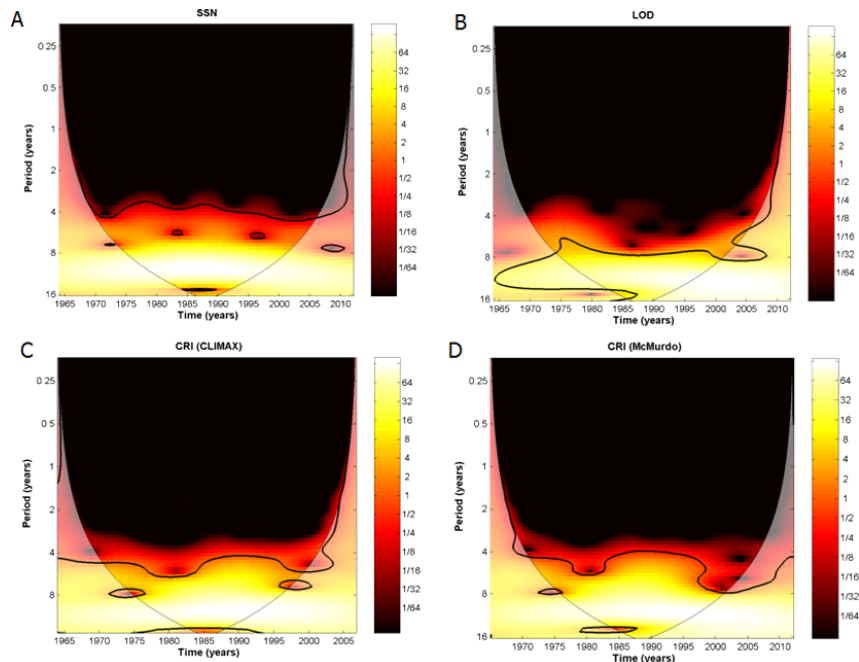
Figure 5. Wavelet spectra of the data presented in Fig. 3 for the time interval closed to analysed: SSN (A) , LOD (B) , CRI Inv (CLIMAX – C , McMurdo – D ). Y axes present periods in years. Wavelet amplitudes are shown by different colours, accordingly to